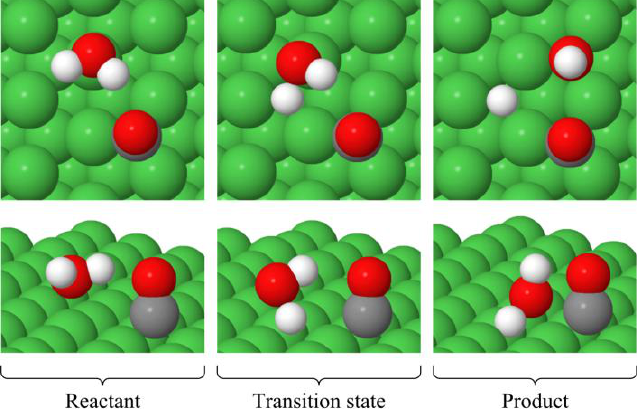
Figure 3. Minimum energy structures of the reactant, transition state and product for the H O * + CO * → OH * + H * + CO * 2